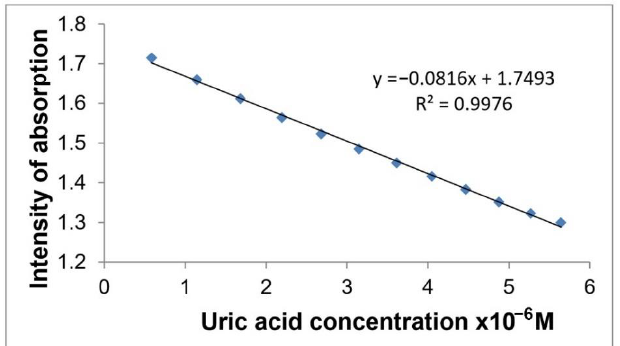
Figure 12. The dependence between the intensity of absorption measured for TAmPP at Soret band (425 nm) and the UA concentration.